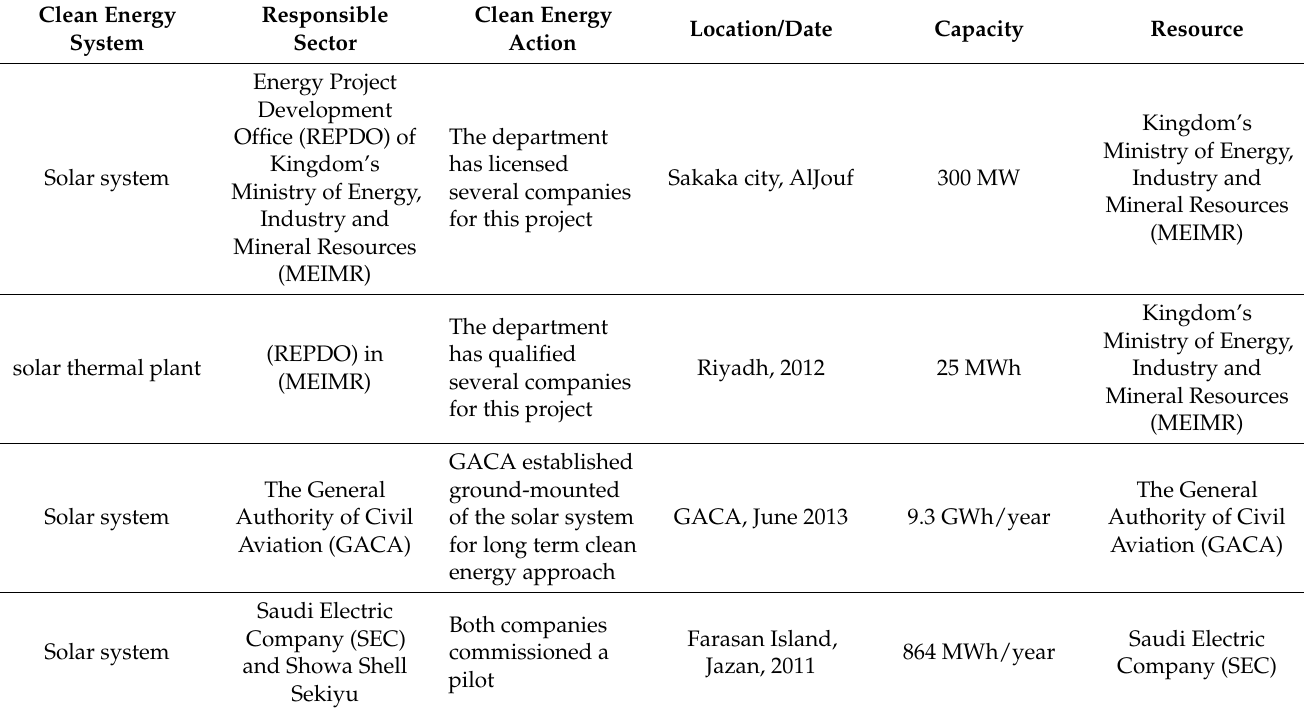
Table A5. Clean energy actions in Saudi